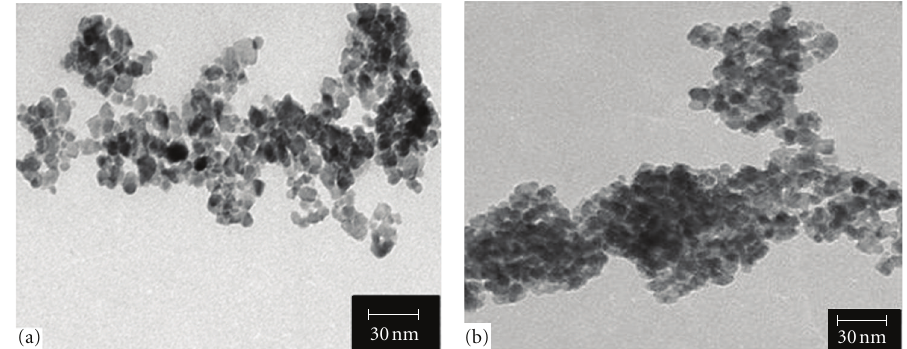
Figure 3: TEM images of (a) TiO 2 , (b) 1.5mol% Sn/TiO 2 nanoparticles.